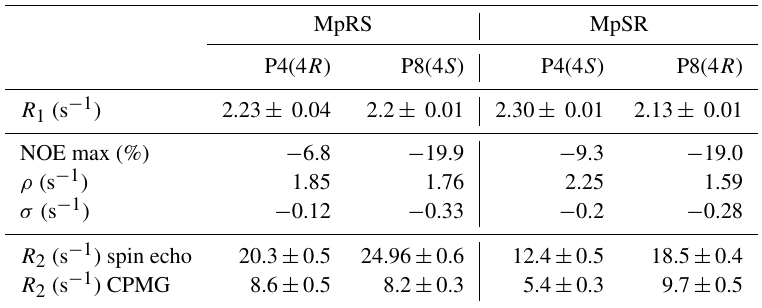
Figure 5. (a) Calculated 19 F longitudinal relaxation rates as functions of rotational correlation time. The lines indicate the range of experi- mental values and their corresponding correlation times. The dotted line indicates a second, unrealistic correlation time for the observed R 1 . (b) Calculated 19 F transverse relaxation rates as functions of rotational correlation time. The lines indicate the range of experimental values and their corresponding correlation times. (c) Calculated steady-state fluorine–proton heteronuclear NOEs. Relaxation data were calculated for (4 R )-FPro in the major C γ - exo (black plain line) and minor C γ - endo (grey plain line) conformations and for (4 S )-FPro for the major C γ - endo (black dashed line) and the minor C γ - exo (grey dashed line) conformations. The lines indicate the range of experimental NOEs and their corresponding correlation times. (d) Experimental NOE build-up at F γ upon selective saturation of H γ proton measured for the MpSR peptide at 298K. The dots are the experimental peak intensities and the solid line is the corresponding fit to a monoexponential function. Table 4. Experimental longitudinal and transverse relaxation rates together with the nuclear Overhauser effect measured for both peptides at 298K on a 600MHz